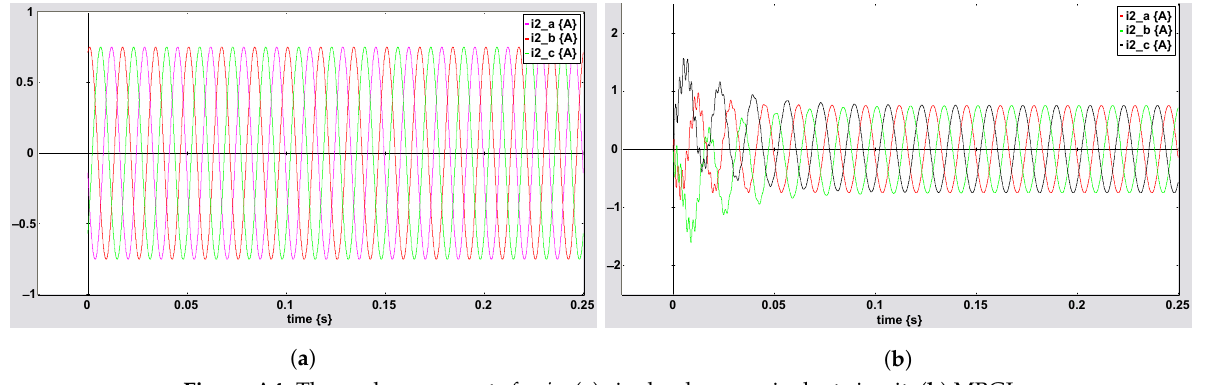
Figure A4. Three-phase currents for i 2 : ( a ) single-phase equivalent circuit; ( b ) MBGI. Figure A5 shows the simulation of the equivalent reduced circuit of Figure A1 and the MBGI of Figure 12 for i 2 simultaneously.